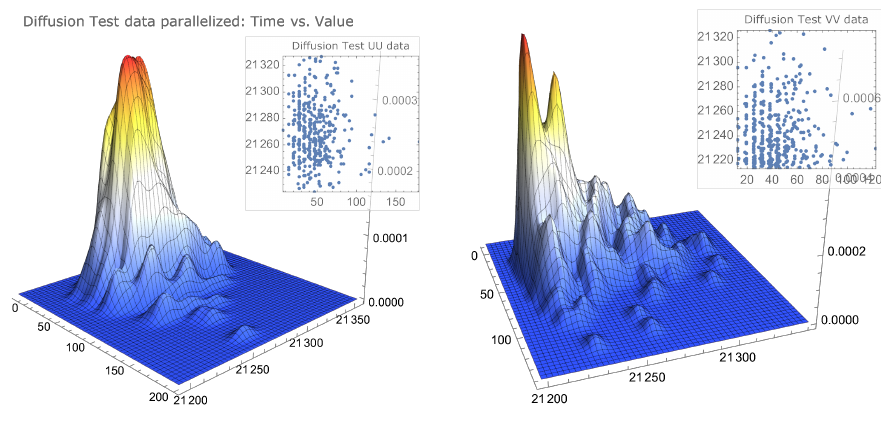
Figure 6. Smoothed distribution of parallelised and nonparallelised simulated